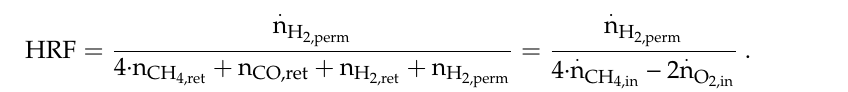
Table 2. Porous metallic support data.